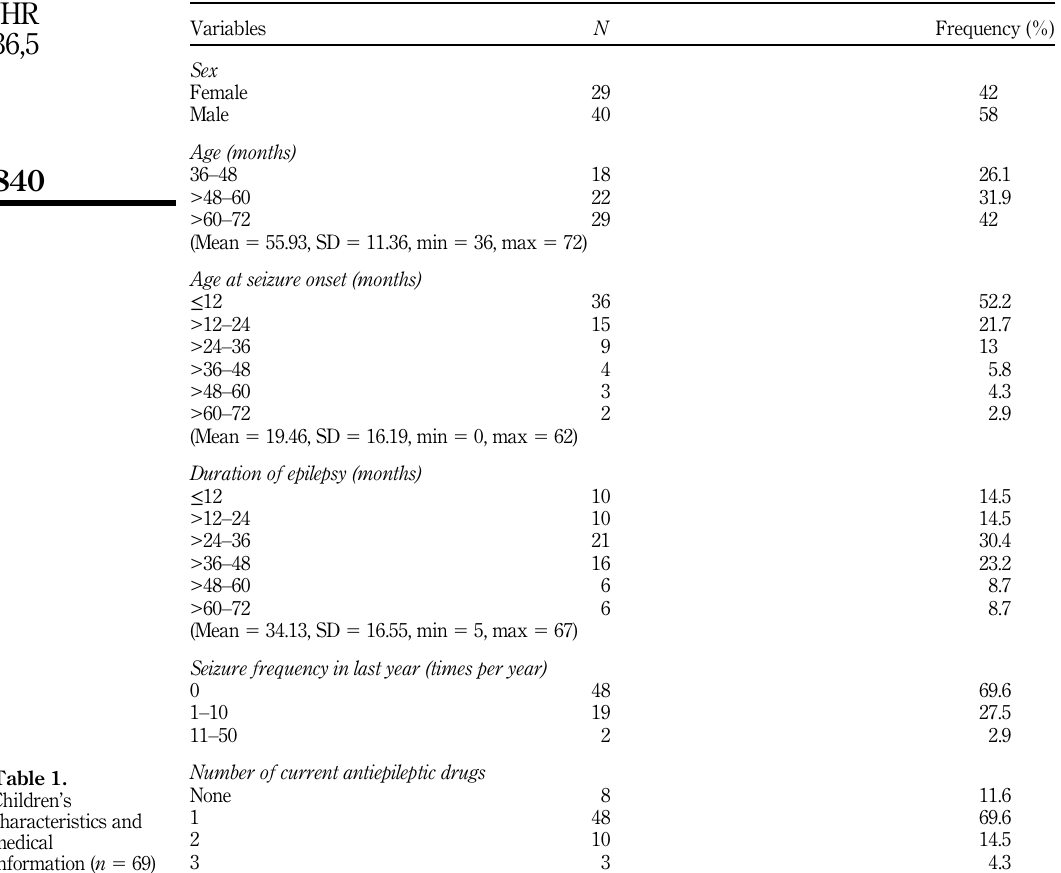
Table 1. Children ’ s characteristics and medical information ( n 5